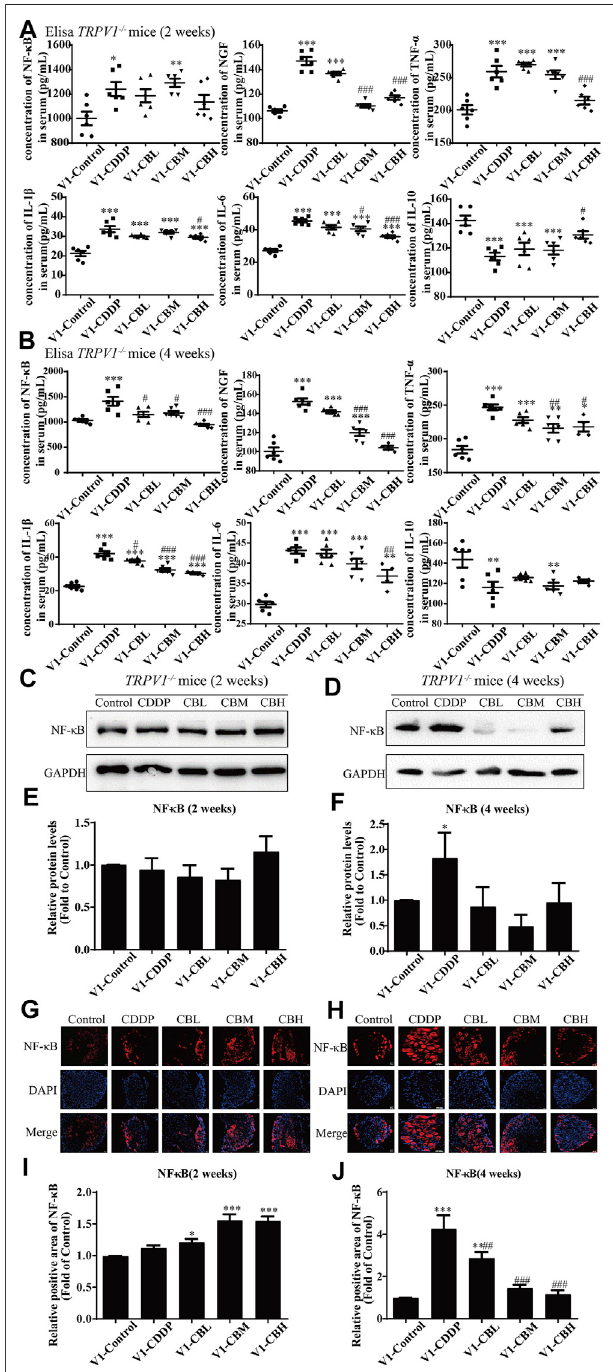
FIGURE 6 | BBR reduces in fl ammation in mice and inhibits the overexpressionofNF- κ Bin TRPV1 − / − miceinducedbyCDDP. (A,B) Expression